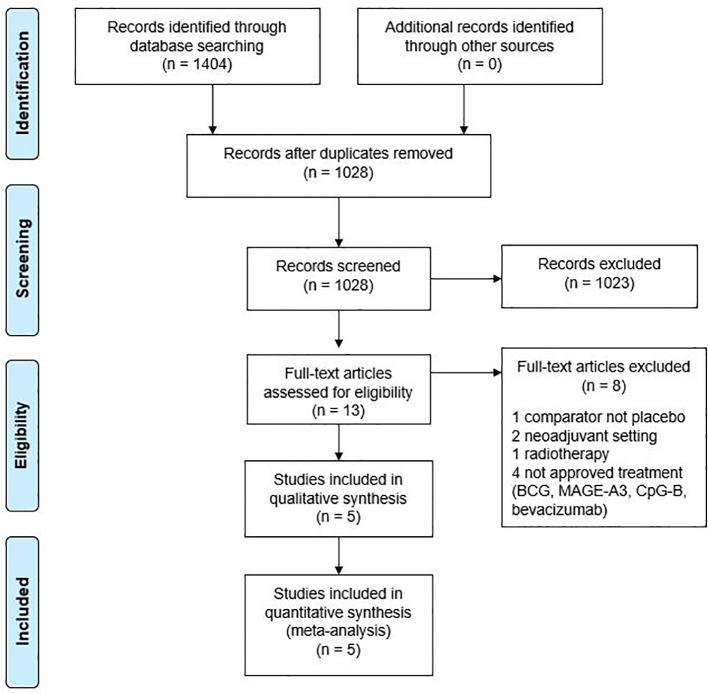
Meta-analysis flowchart. BCG, bacillus Calmette-Guerin; MAGE-A3, melanoma antigen A3.